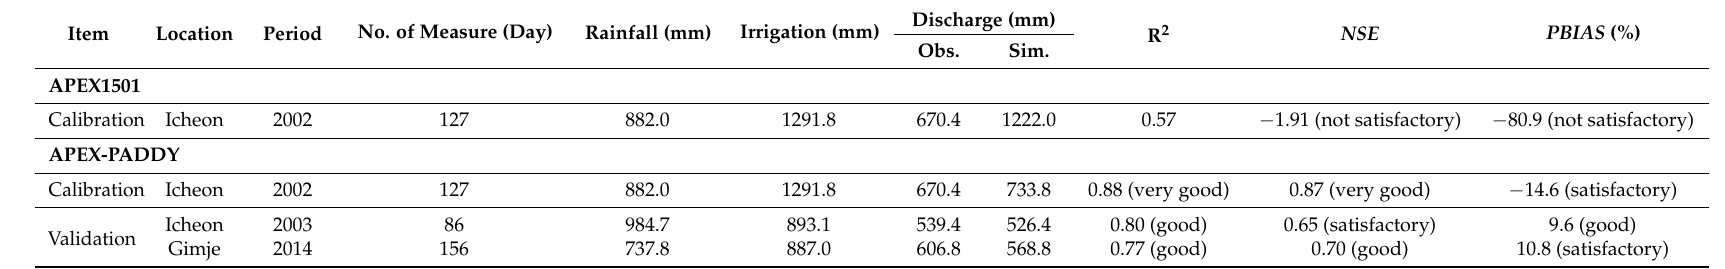
Table 4. Summary of calibration and validation results for daily discharge at the study